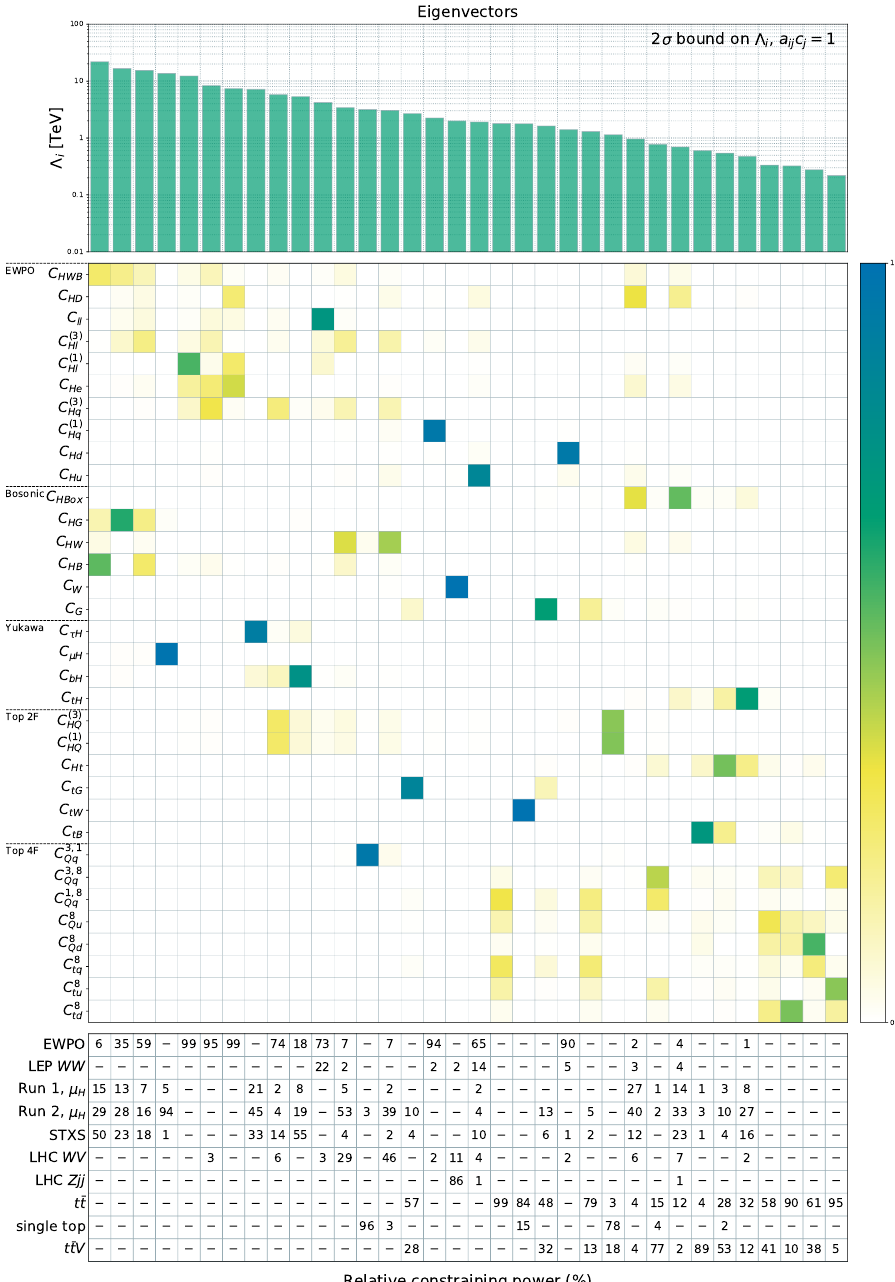
Figure 13 . Constraints on the eigenvectors of the global likelihood function. The top panel shows the strengths of the global constraints on the eigenvectors. The rows in the centre panel correspond to the different operator coefficients, the rows correspond to the different eigenvectors, and the colour-coded squares represent the moduli-squared of the operator components to the eigenvectors. The bottom panel shows the constraining powers of the electroweak precision data, LEP diboson data, Higgs coupling strength measurements from Runs 1 and 2, STXS, LHC diboson and Zjj , t ¯ t , single-top and t ¯ tW/Z/γ measurements, respectively. Instances where there is no significant constraining power are indicated by “-”. Explicit expressions for the eigenvectors are given